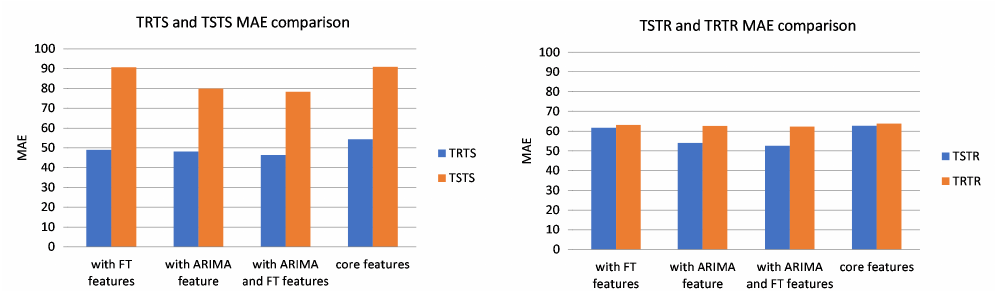
Figure 11. MAE comparison between TRTS/TSTS and TSTR/TRTR (UCI data